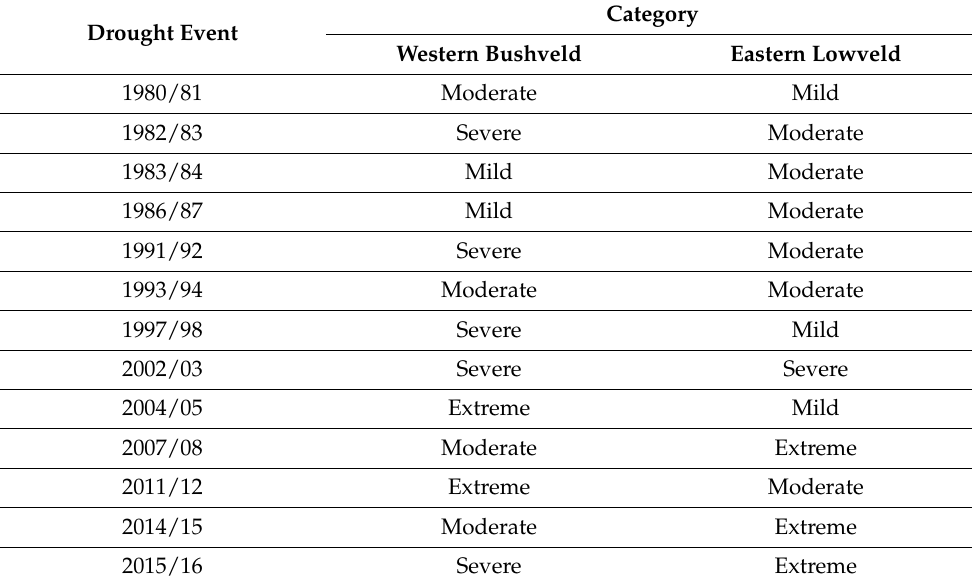
Table 6. Drought Events in Mopani District Municipality and their